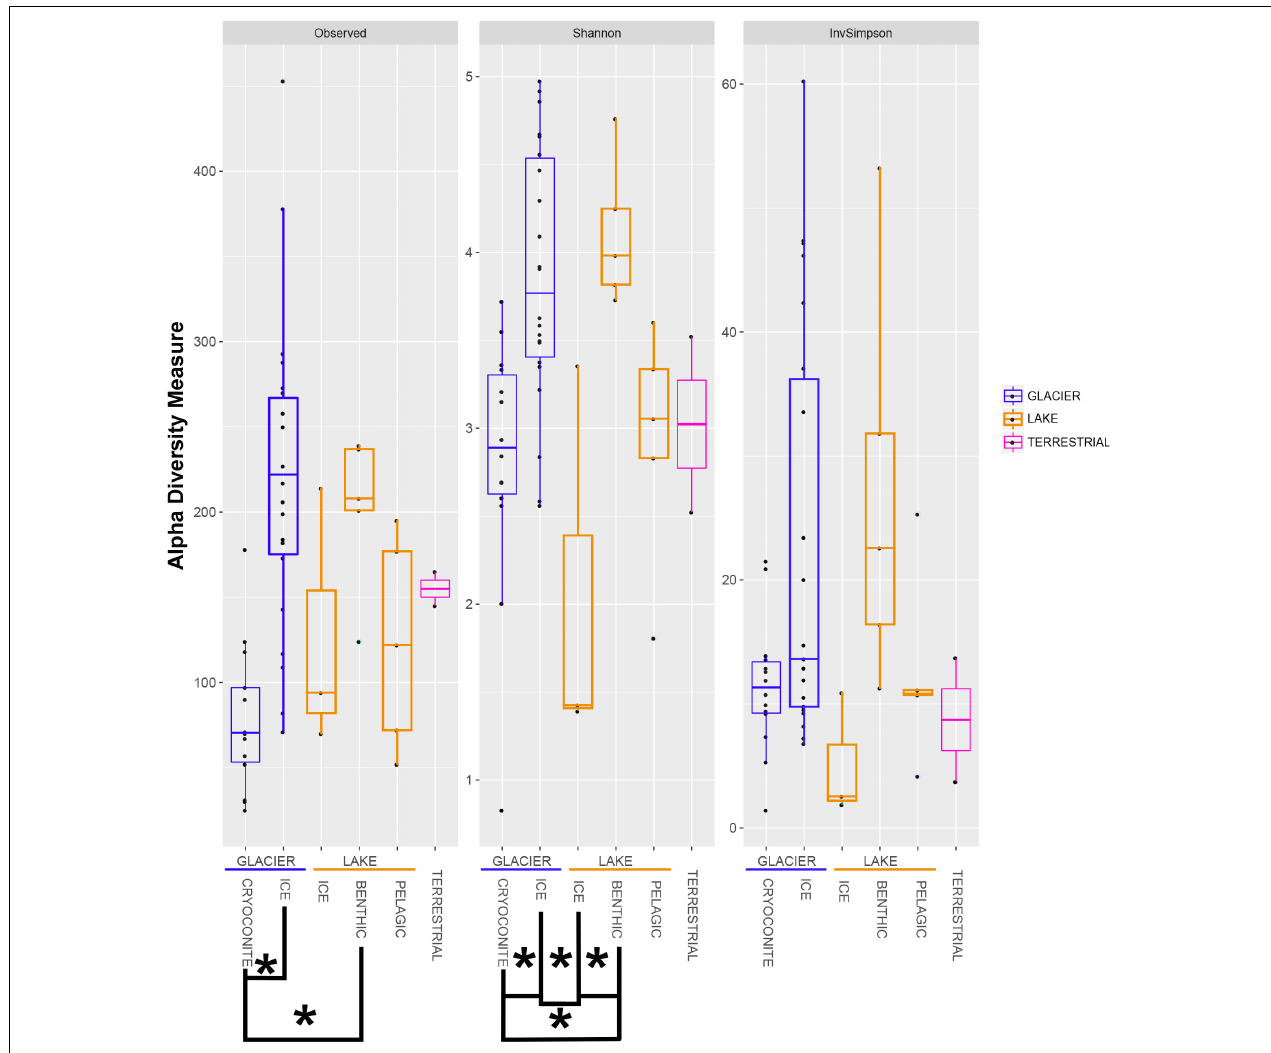
FIGURE 5 | The alpha diversity indices Observed, Shannon and InvSimpson are shown in boxplots. All samples are grouped into similar habitats. Significant differences are marked with clamps and